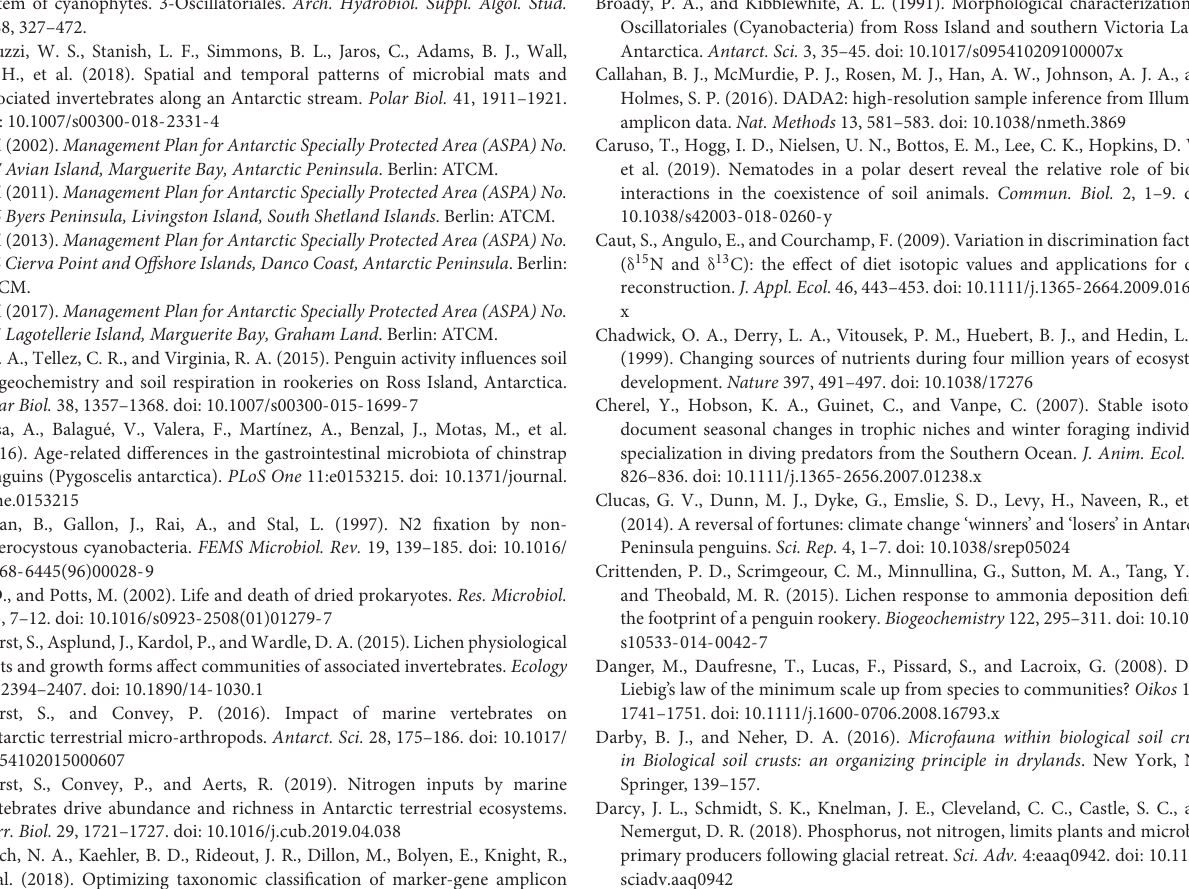
nematode found in CP.